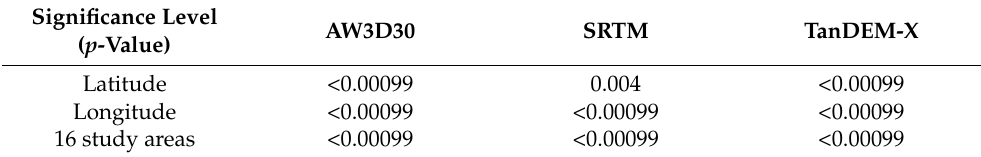
Table 6. Kruskal–Wallis test on latitudes and longitudes.